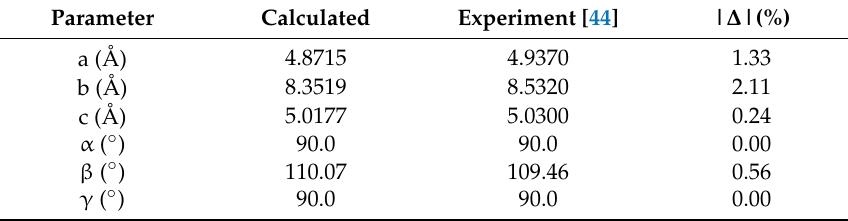
Figure 1. Crystal structure of Li 2 MnO 3 (space group C 2/m). Table 1. Calculated structural parameters and corresponding experimental values [44] reported for monoclinic (C2/m) Li 2 MnO 3